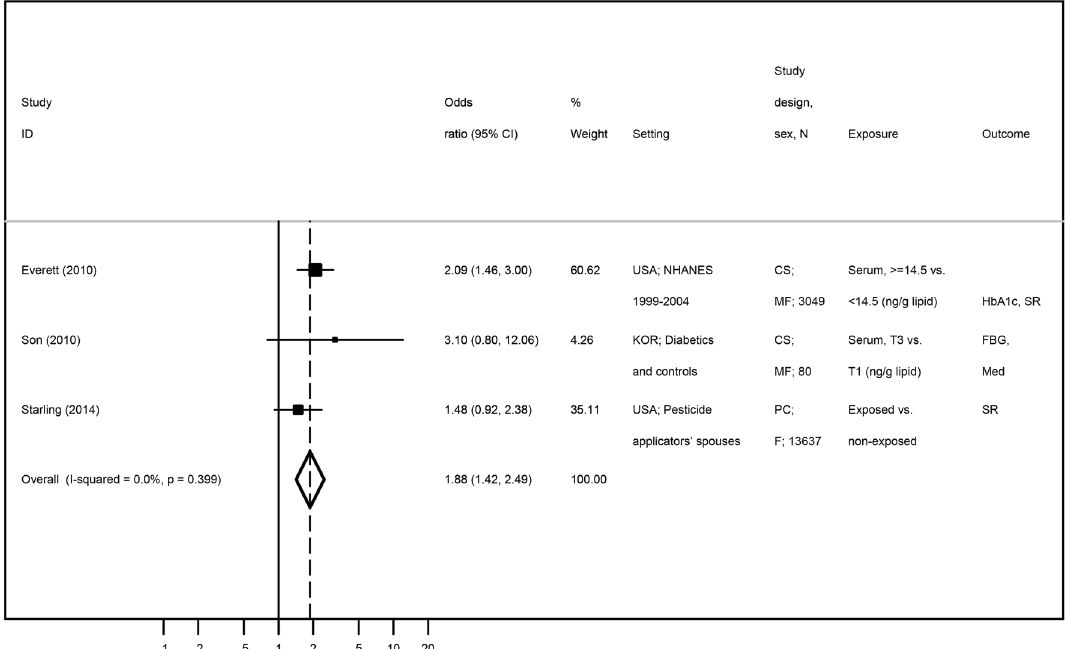
Figure 6. Meta-analysis of studies evaluating the association of heptachlor epoxide with diabetes-related features in adults. Odds ratios and corresponding 95% CI (horizontal lines). The size of the black square indicates the study’s weight in the analysis (weights are from fixed-effects analysis). The centre of the open diamond indicates the summary estimate and its width represents the 95%